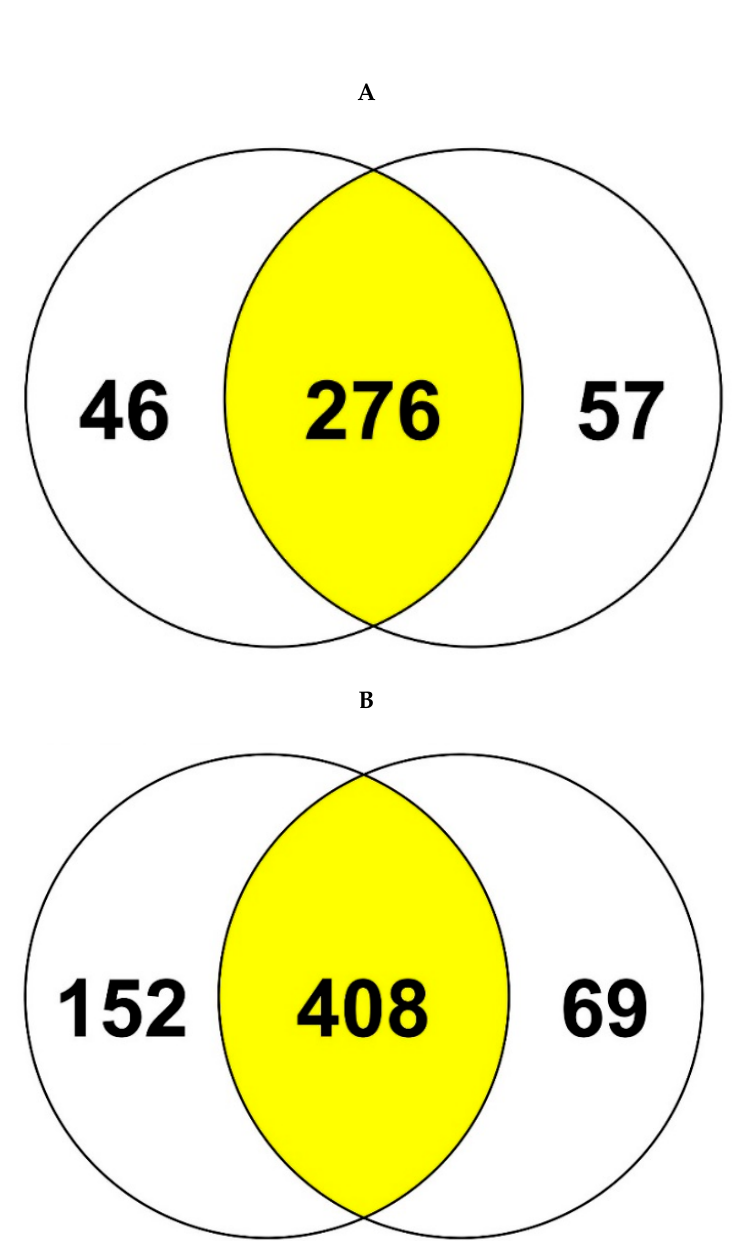
Figure 6. Proteomics data plotted as a Venn diagrams from ( A ) Burkholderia sp. strain SRS-25 and ( B ) Burkholderia sp. strain SRS-46 ( B ), respectively. Venn diagram sectors represent proteins expressed in control (left circle) and uranium treated (right circle). The yellow segment represents the number of commonly expressed proteins between untreated and U treated samples. Table 2. List of upregulated proteins in SRS-25 and SRS-46 strains, following exposure to uranium. Fold change represents the expression with U amendment normalized to expression without U, respectively. Function